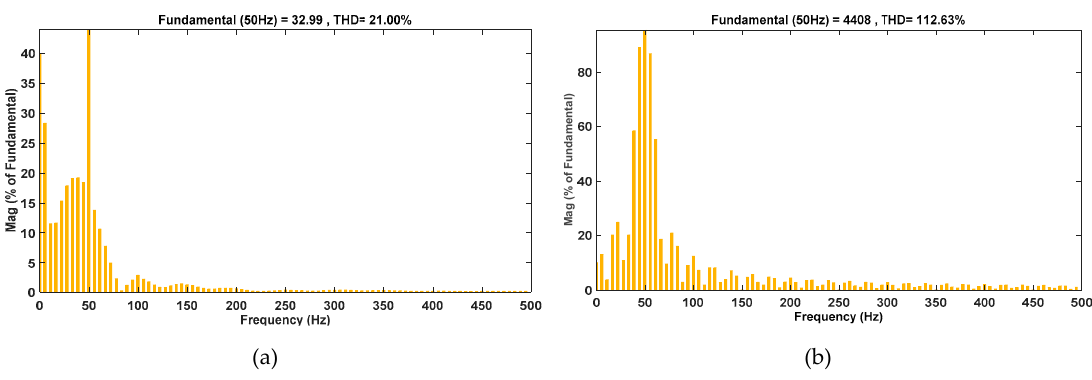
Figure 15. THD with LM + Crowbar scheme for grid current ( a ) and voltage ( b ) during the P-G fault.